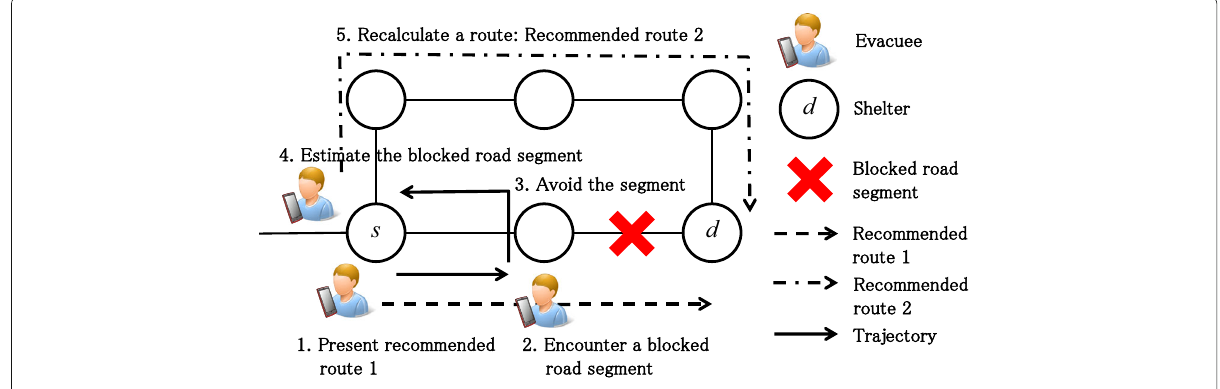
Fig. 1 The flow of the automatic evacuation